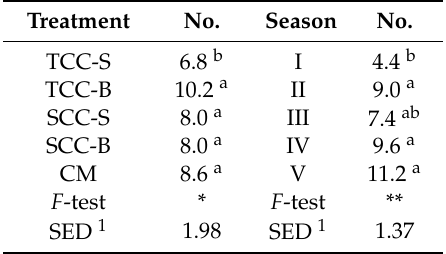
Table 2. Mean weed species richness found in 5 cropping systems and 5 seasons. Treatment